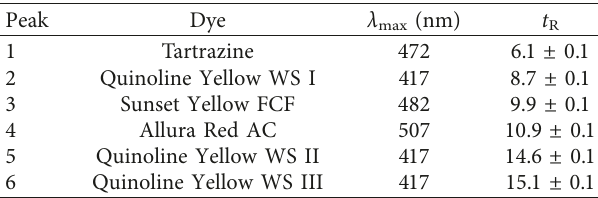
Table 3: Chromatographic data of the dyes with the optimized gradient program in this study.